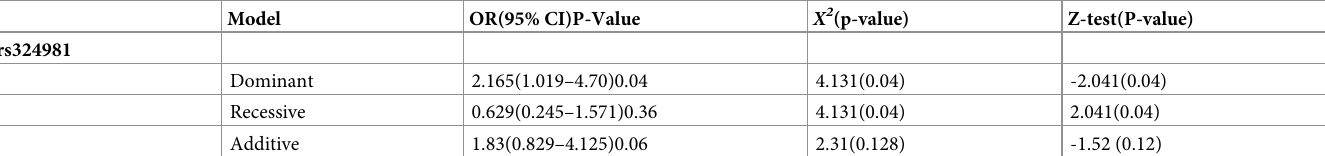
Table 2. Genotypic distribution of NPSR1 (rs324981, A > T) in normal controls (n = 59) and obese (n = 57) Pakistani